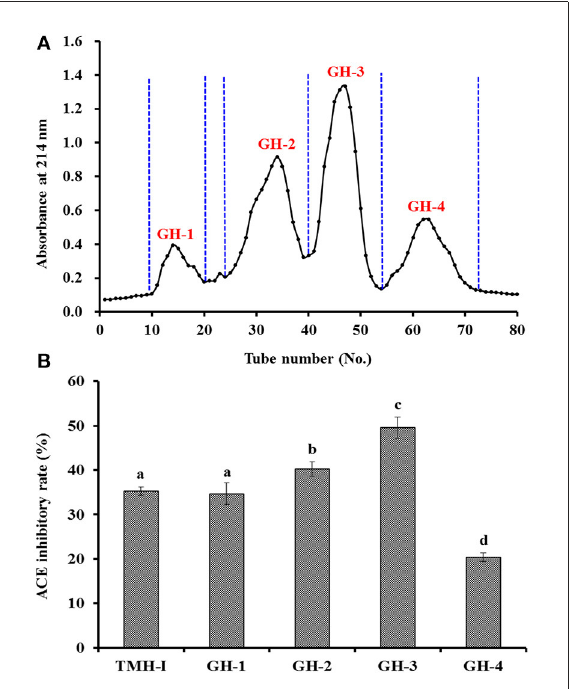
FIGURE3 Chromatogram profiles of TMH-I isolated by Sephadex G-25 (A) and ACEi rates of prepared subfractions (GH-1–GH-4)